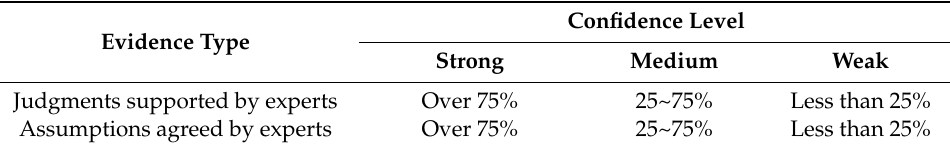
Table 9. Definition of data confidence levels [27].